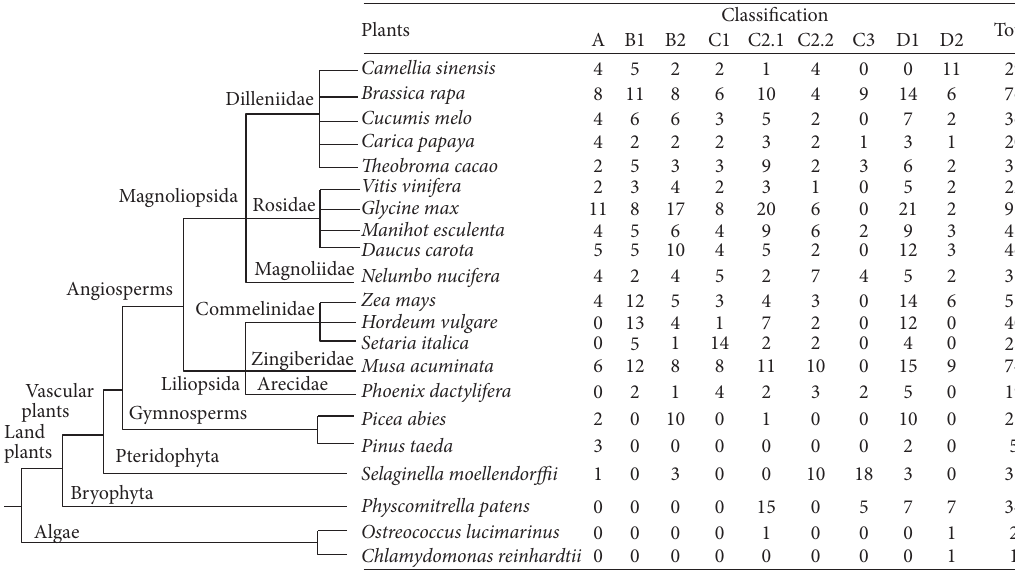
Figure 6: Comparisons of Dof TFs in different